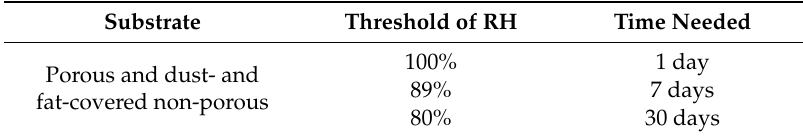
Table 1. The thresholds of relative humidity (RH) and time for mould germination [30] Substrate Threshold of RH Time Needed 100% 1 day Porous and dust- and 89% 7 days fat-covered non-porous 80% 30